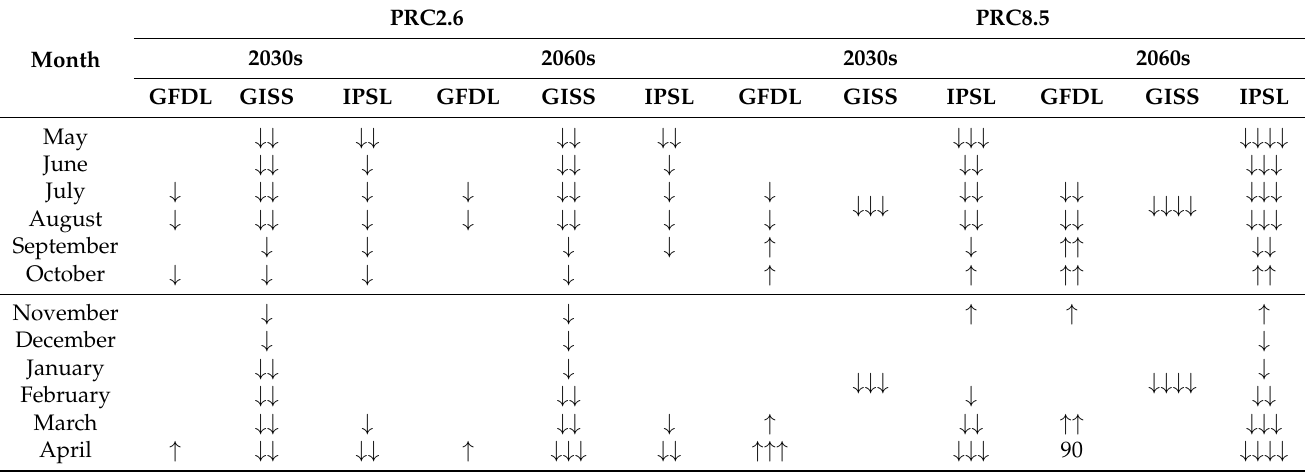
Figure 4. Comparison of baseline and future streamflow in different GCMs of RCP2.6 and RCP8.5 for near future (2030s) and medium future (2060s). Table 9. Percentage changes range in project mean monthly